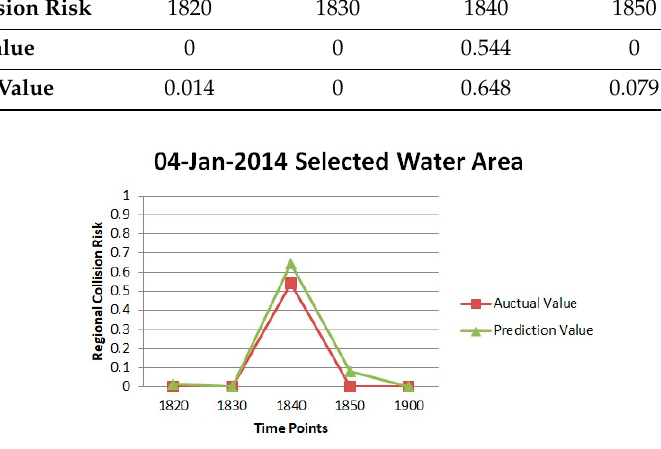
Figure 18. 04-Jan-2014 Regional collision risk.